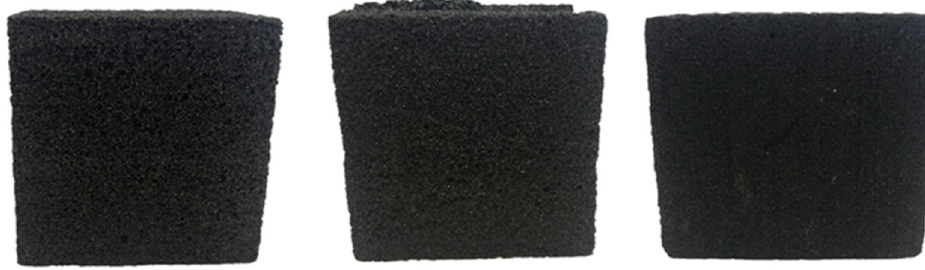
Figure 1. Left to right: Mimosa, quebracho, chestnut foam produced with 10% surfactant. Producing foams with the exact same formulation by just changing the tannin type was not possible due to the different reactivity of condensed and hydrolysable tannin. For instance, using 2 mol/L sulphuric acid in combination for condensed tannins is effective, whereas for chestnut the foam collapsed before curing.